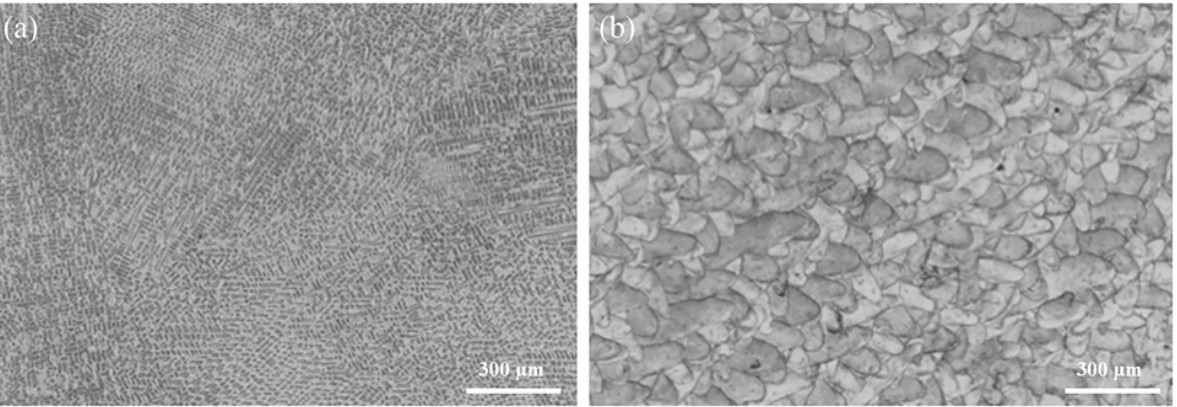
Figure 2. Metallurgical-microscopy images of the Co-Cr alloys produced via ( a ) CAST and ( b ) SLM.